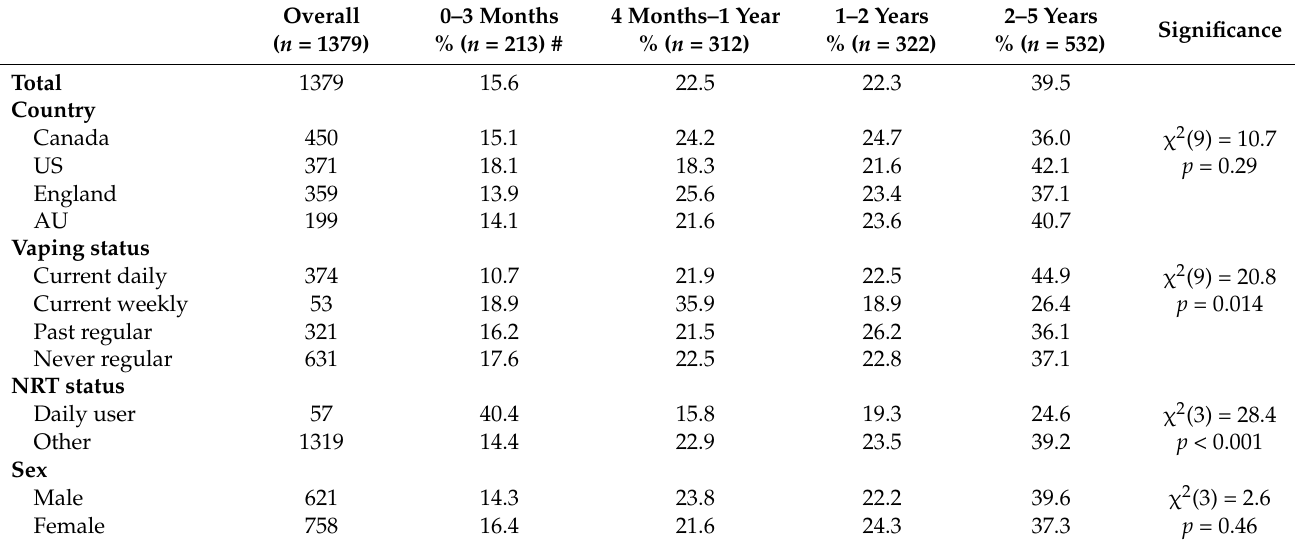
Table 1. Sample characteristics, by duration of time